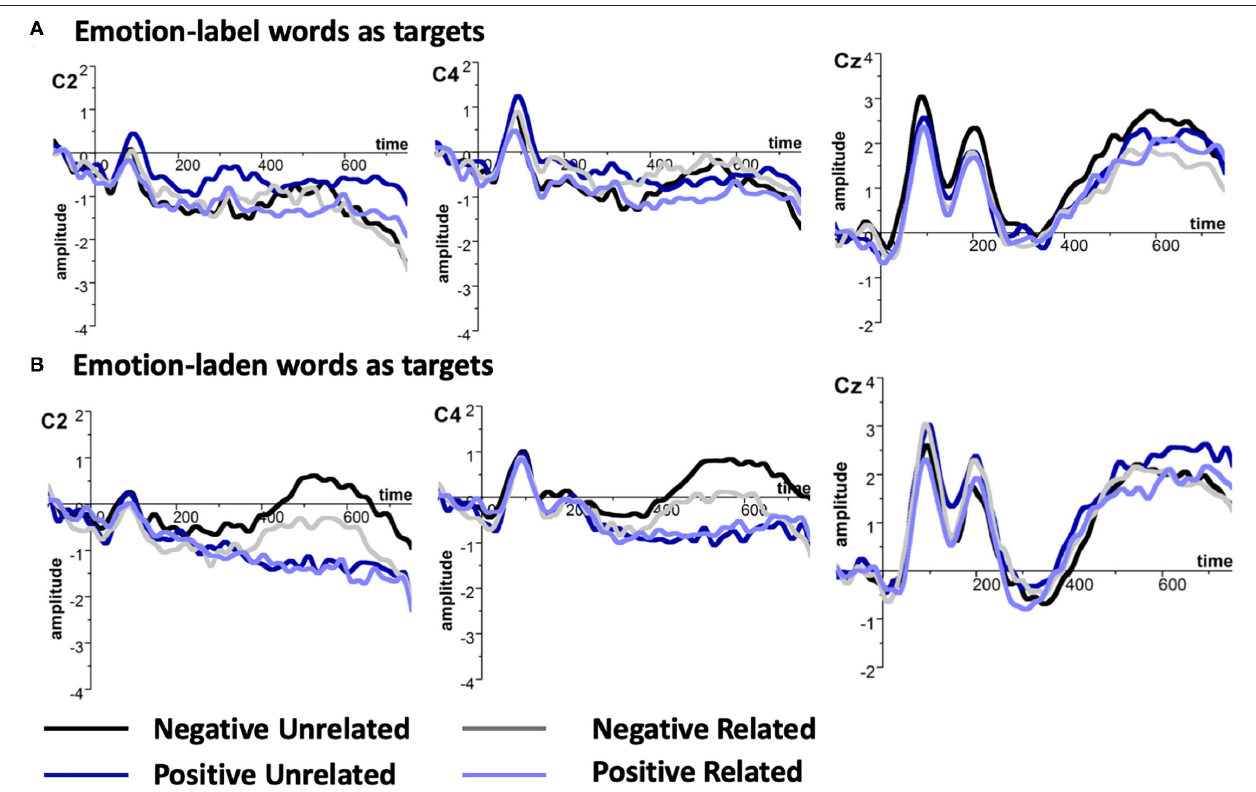
FIGURE 1 | Grand average event-related potentials (ERPs) of late positivity complex (LPC) at selected electrodes (A) emotion-label words and (B) emotion-laden words as primes, amplitude ( µ V), and time (ms).